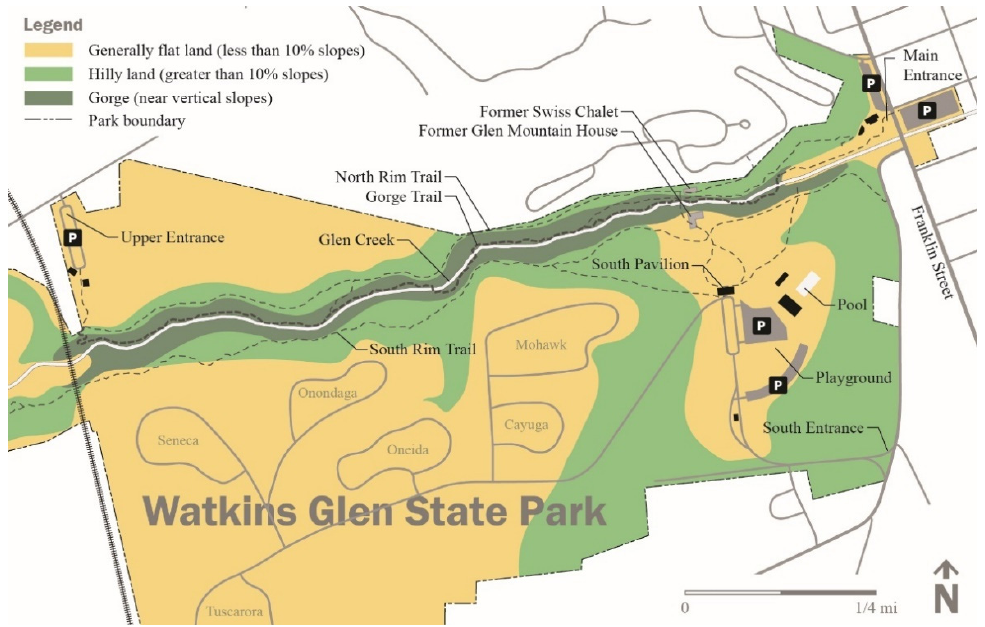
Figure 6. Map of the east side of Watkins Glen State Park in 2020, by author. Topographic information based on United States Geological Survey 2019 Quadrangle Maps.